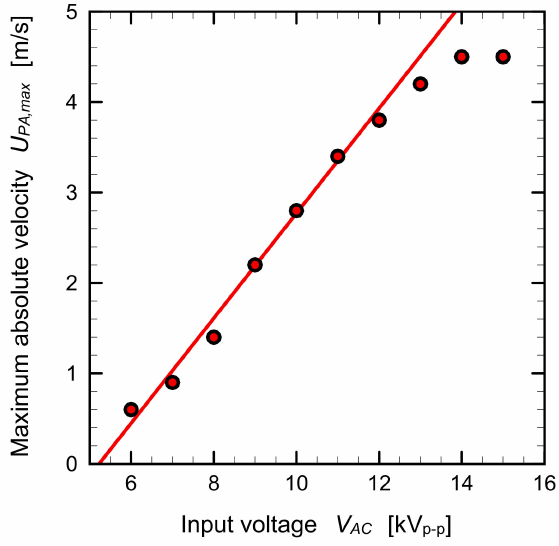
Figure 7. Maximum absolute velocity induced by plasma actuator at various input